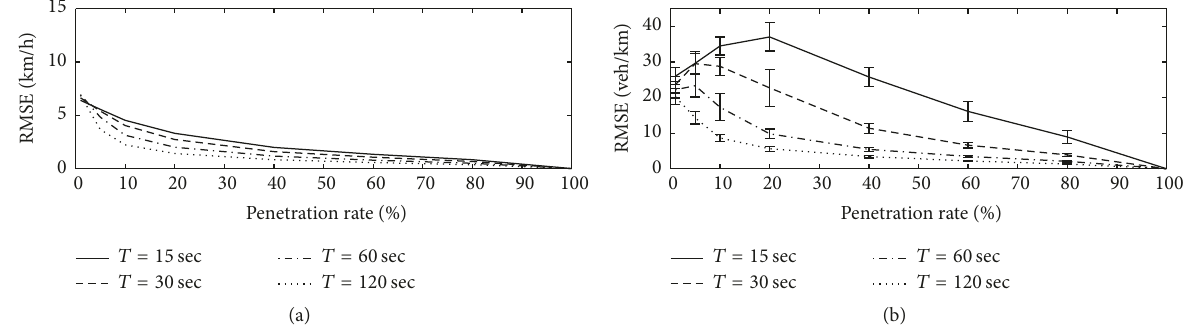
Figure 5: Mean RMSE for the estimated speed (a) and density (b) compared to the reference density and speed for CCV at different penetration rates and for different aggregation time periods. The error bars in (b) are based on 95% confidence intervals, assuming normally distributed RMSE over the simulation runs. The standard error of mean in (a) is at most 0.44 km/h, and hence the confidence intervals are excluded from the figure for greater legibility.